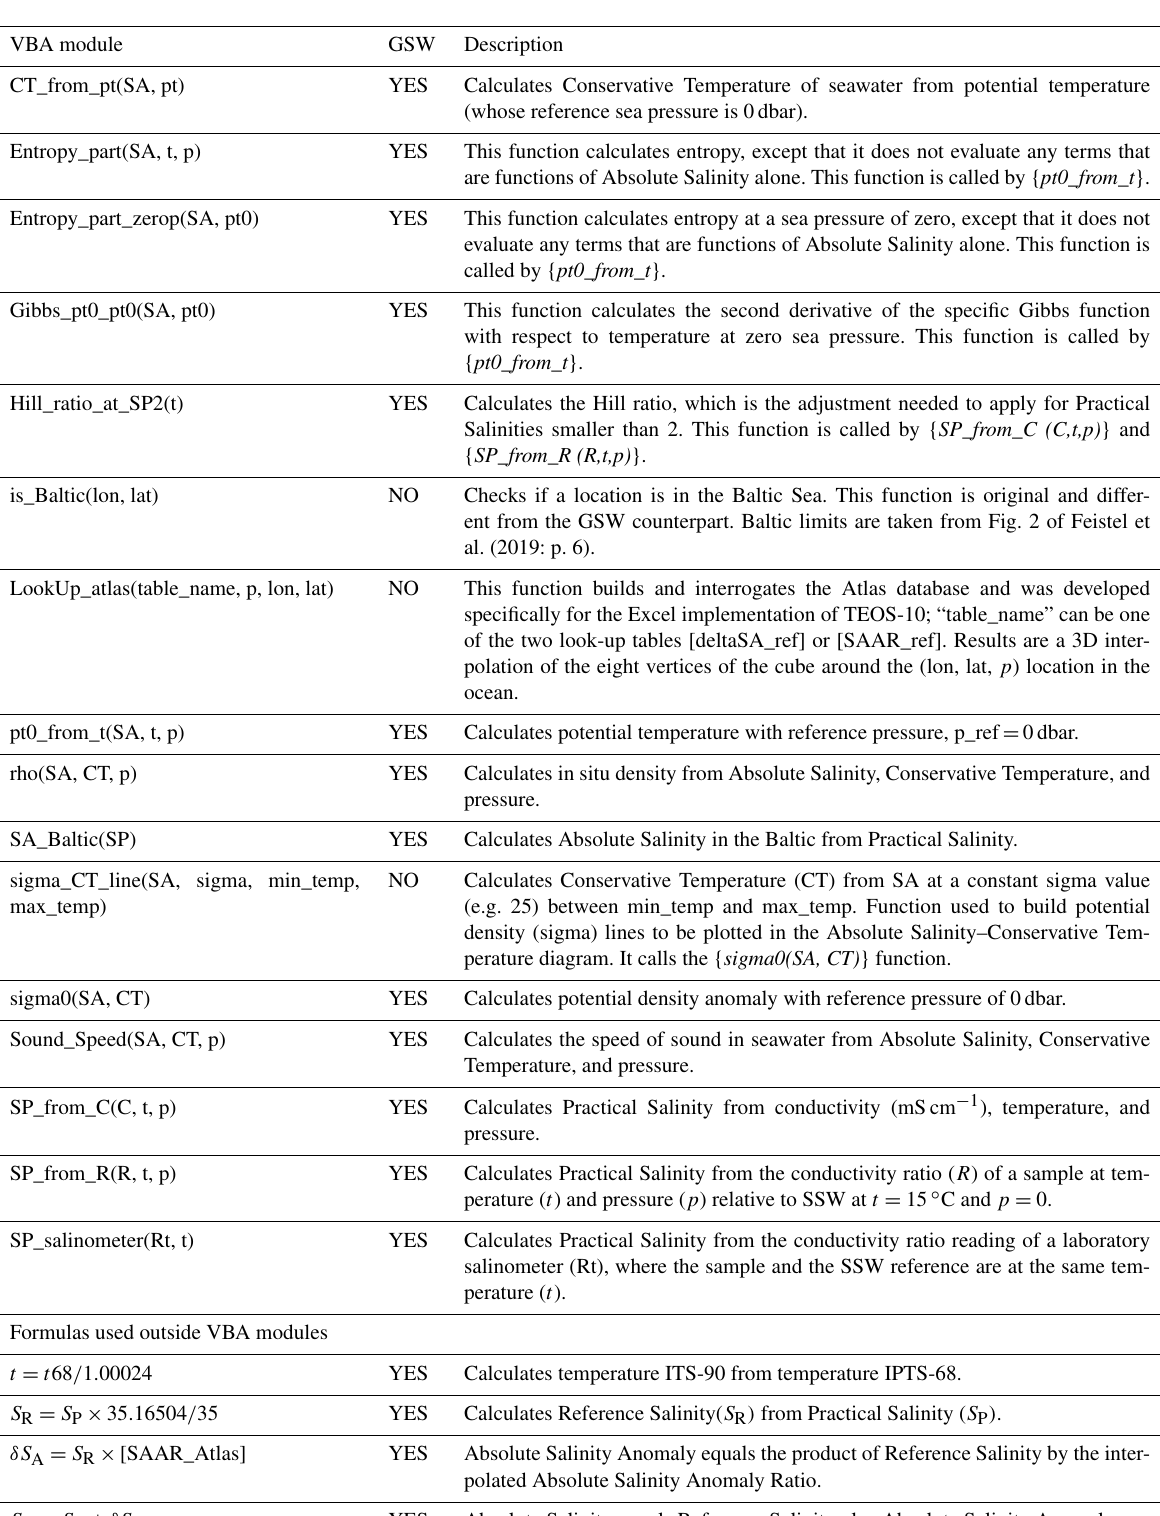
Table 1. List of all VBA modules and formulas included in TEOS-10 Excel (v.2.1). Direct translations from GSW are marked with “YES”, and original or modified functions are marked with